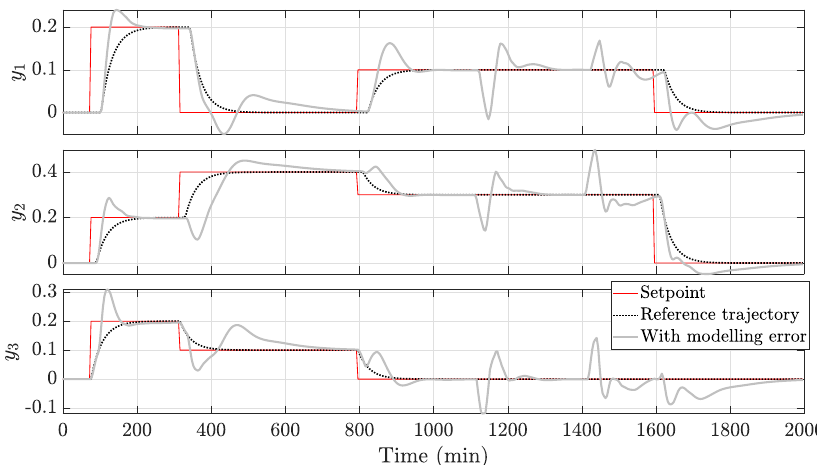
Figure 15. Case 2—Response of the HOF outputs to setpoint changes and disturbance rejections with uncertainties.